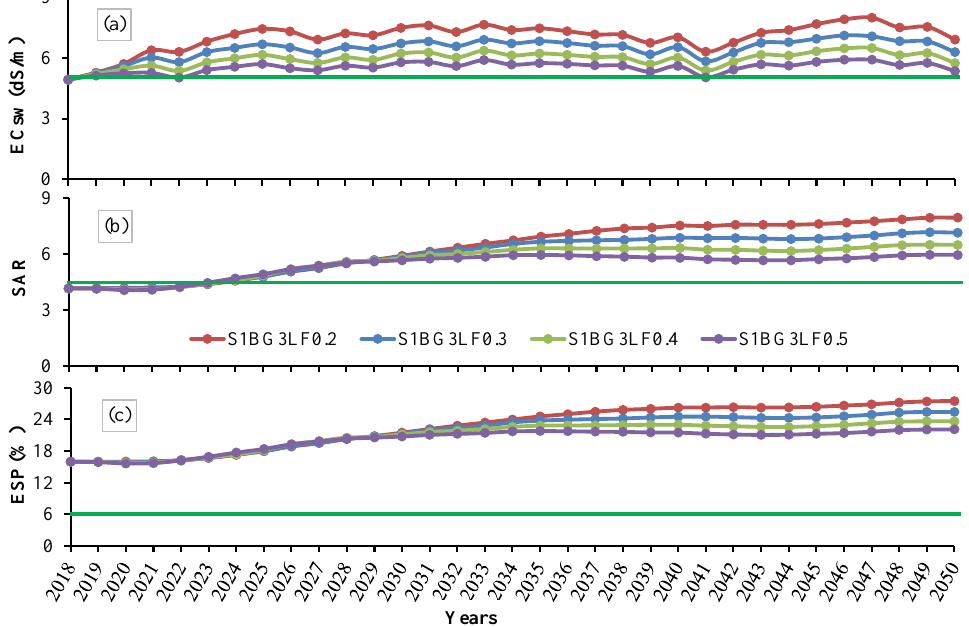
Figure 7. Impact of different leaching fractions (LF0.2, LF0.3, LF0.4, and LF0.5) and annual gypsum applications of 8.6 t/ha (G3) on ( a ) EC sw , ( b ) SAR, and ( c ) ESP in the 90–120 cm soil layer in the calcareous soil (S1) under a 1:1 blend of recycled (RW) and SA water (GW) irrigation of wine grapes.